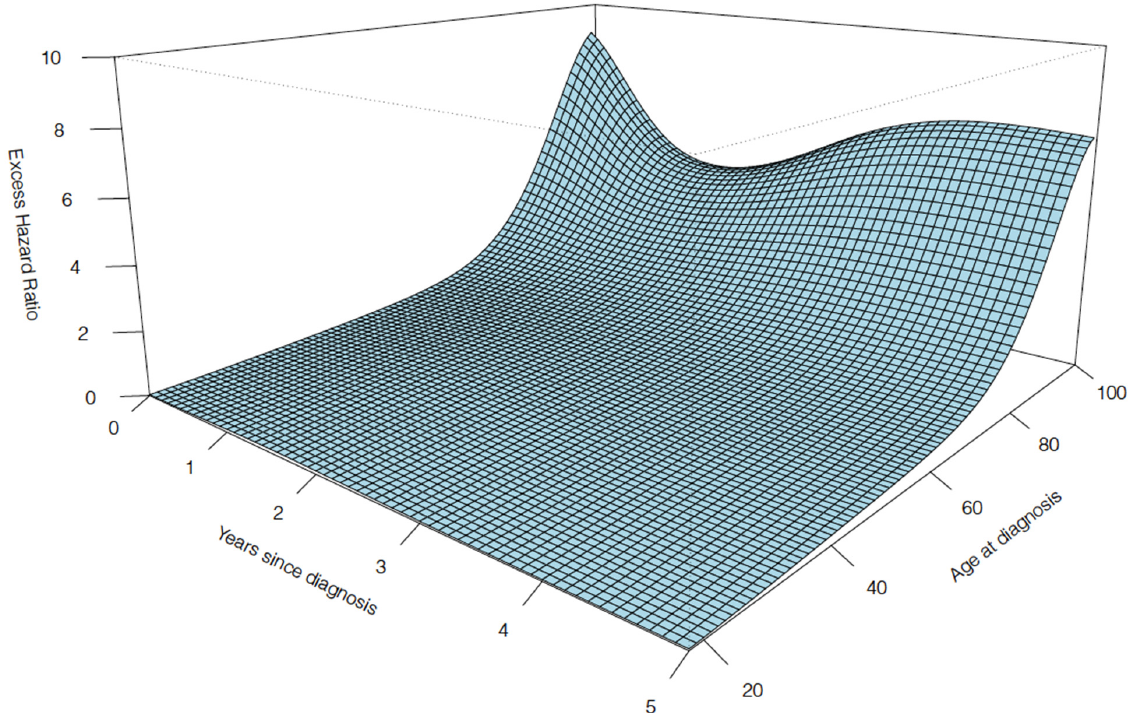
Figure A4. Excess mortality hazard ratio according to age at diagnosis and time since diagnosis for patients diagnosed with follicular lymphoma ( n = 15,516) in England between 2005 and 2013.